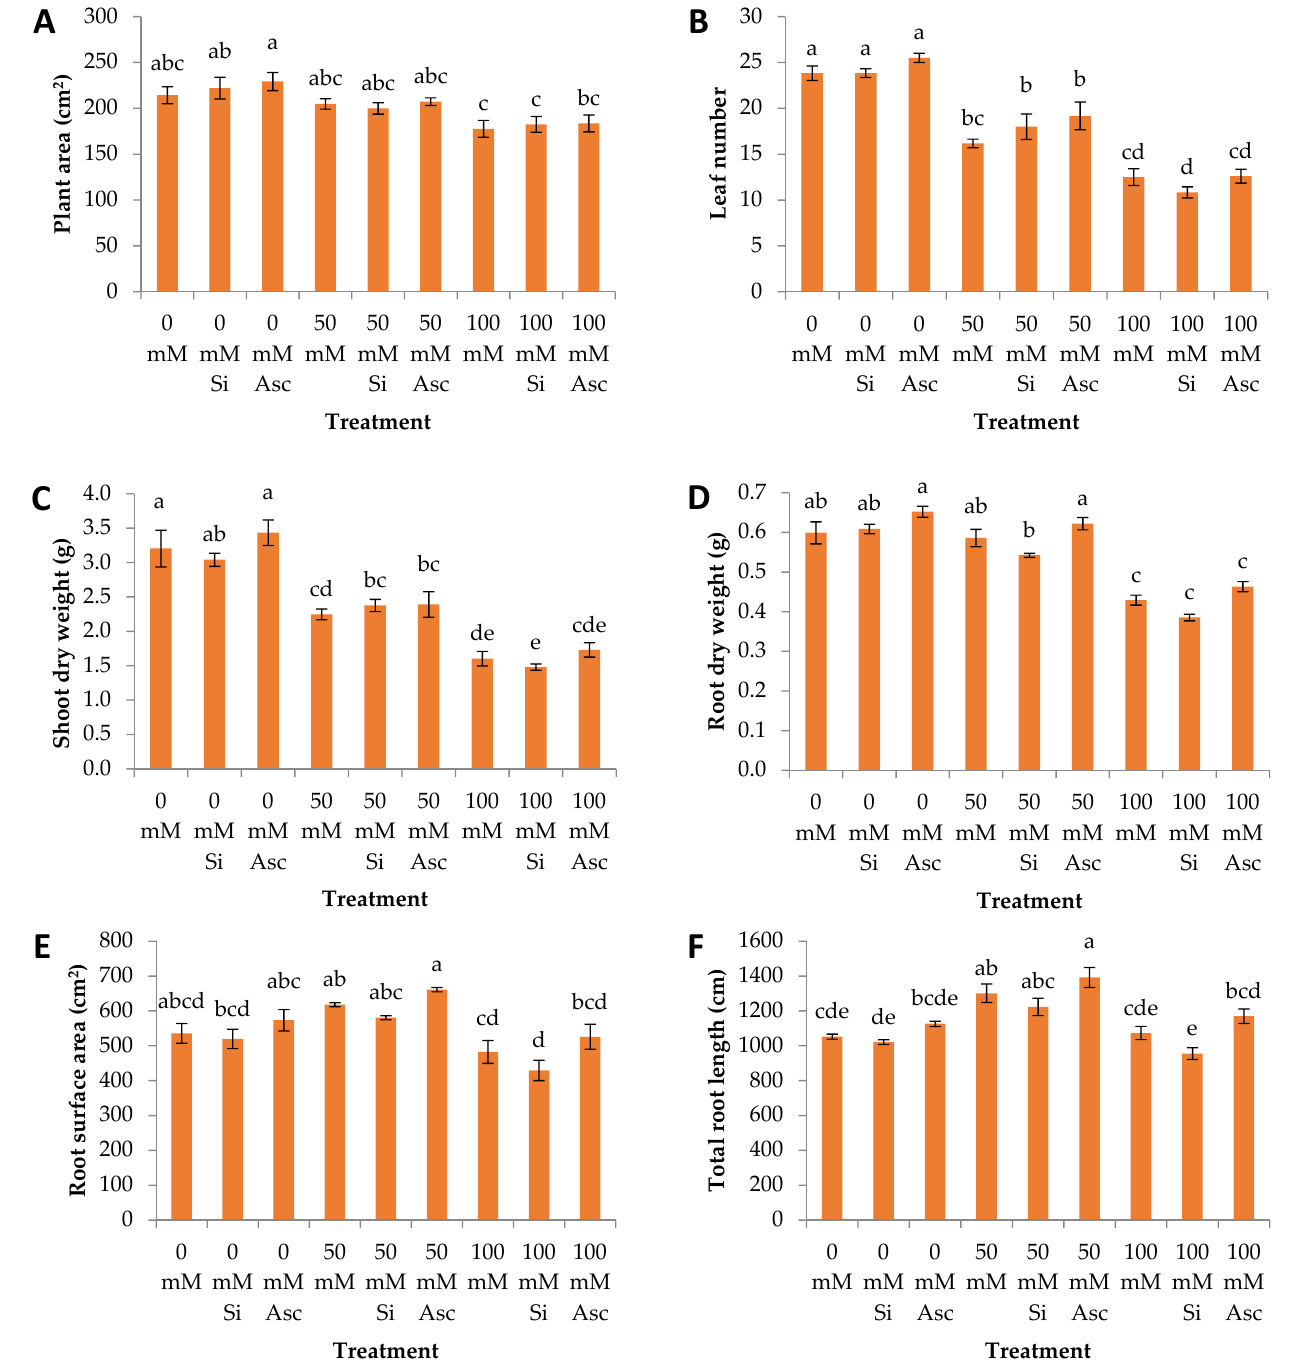
Figure 1. ( A ) Plant area, ( B ) leaf number, ( C ) shoot dry weight, ( D ) root dry weight, ( E ) root surface area, and ( F ) total root length of watermelon transplants irrigated with nutrient solution of different NaCl concentration and sprayed with two biostimulants. Within a bar, average values (n = 5) followed by different letters are significantly different (a < 0.05).